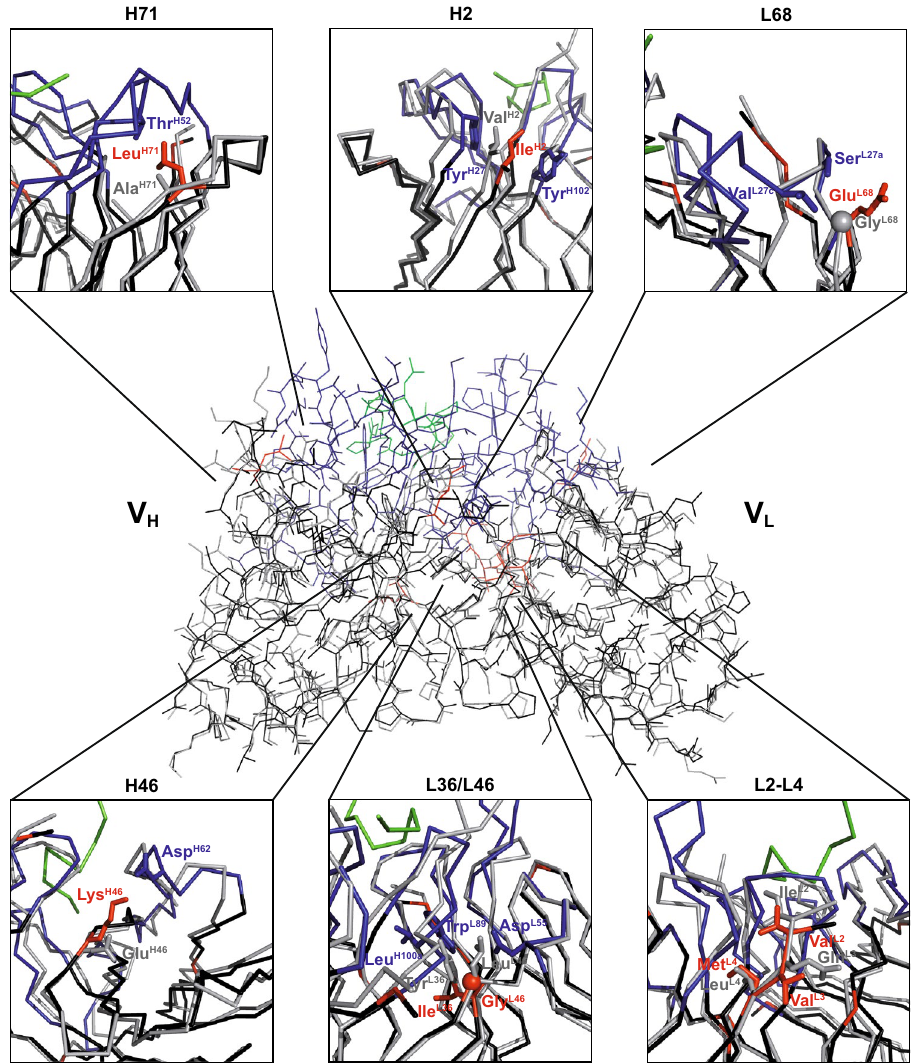
Figure 4. Structural superposition of the chimeric αhGal3-Fab with the crystal structure of mAb m66 (PDB ID: 4NRY) via Cα positions of the framework regions in both variable domains. The framework residues of the αhGal3-Fab are shown in black, V H CDRs in dark blue, V L CDRs in light blue, the hGal3 epitope peptide in green, the m66 framework residues in grey. Side chains of the backmutated framework residues are highlighted as sticks (αhGal3-Fab: red; m66: grey; structurally interfering residues: blue, see text). Graphics were prepared using PyMOL version 1.30 (https:// www. schro dinger.